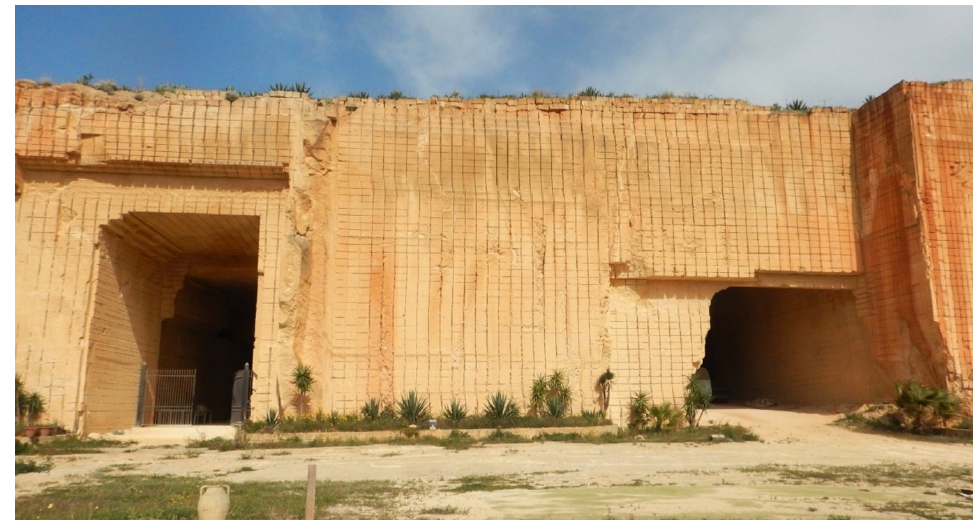
Figure 9. The Foderà Quarry in Marsala, Sicily. View of the entrances of the main tunnels.